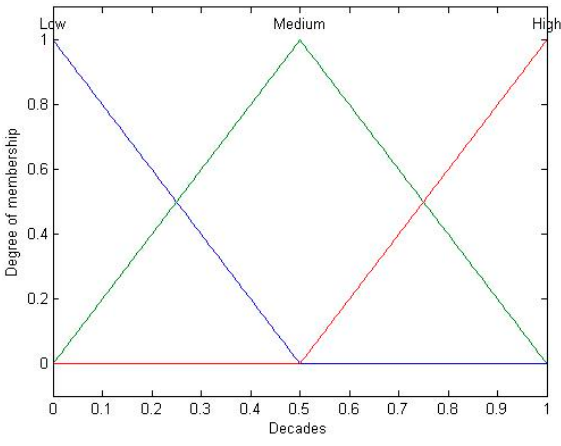
Figure 12. Input called Decades.